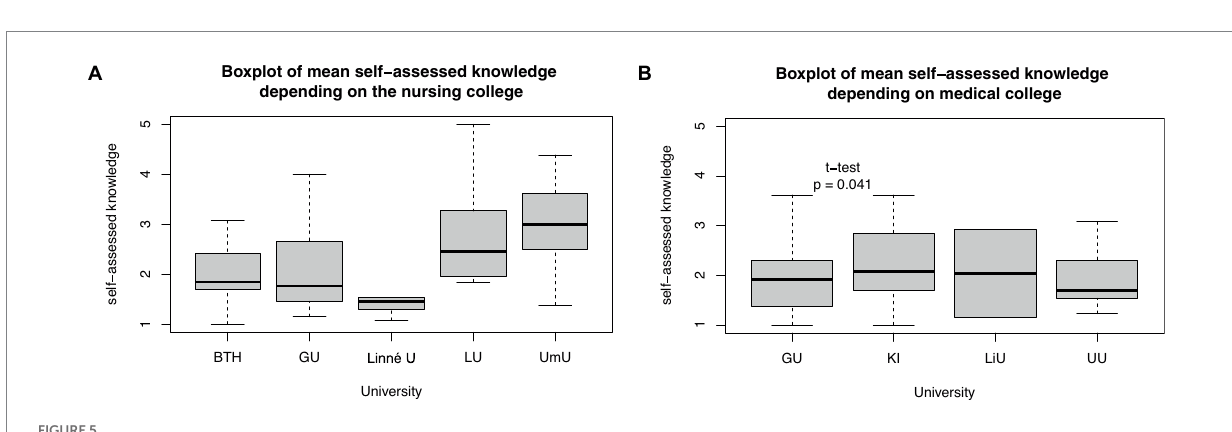
FIGURE 5 Differences in mean self-assessed knowledge depending on the (A) nursing and (B) medical